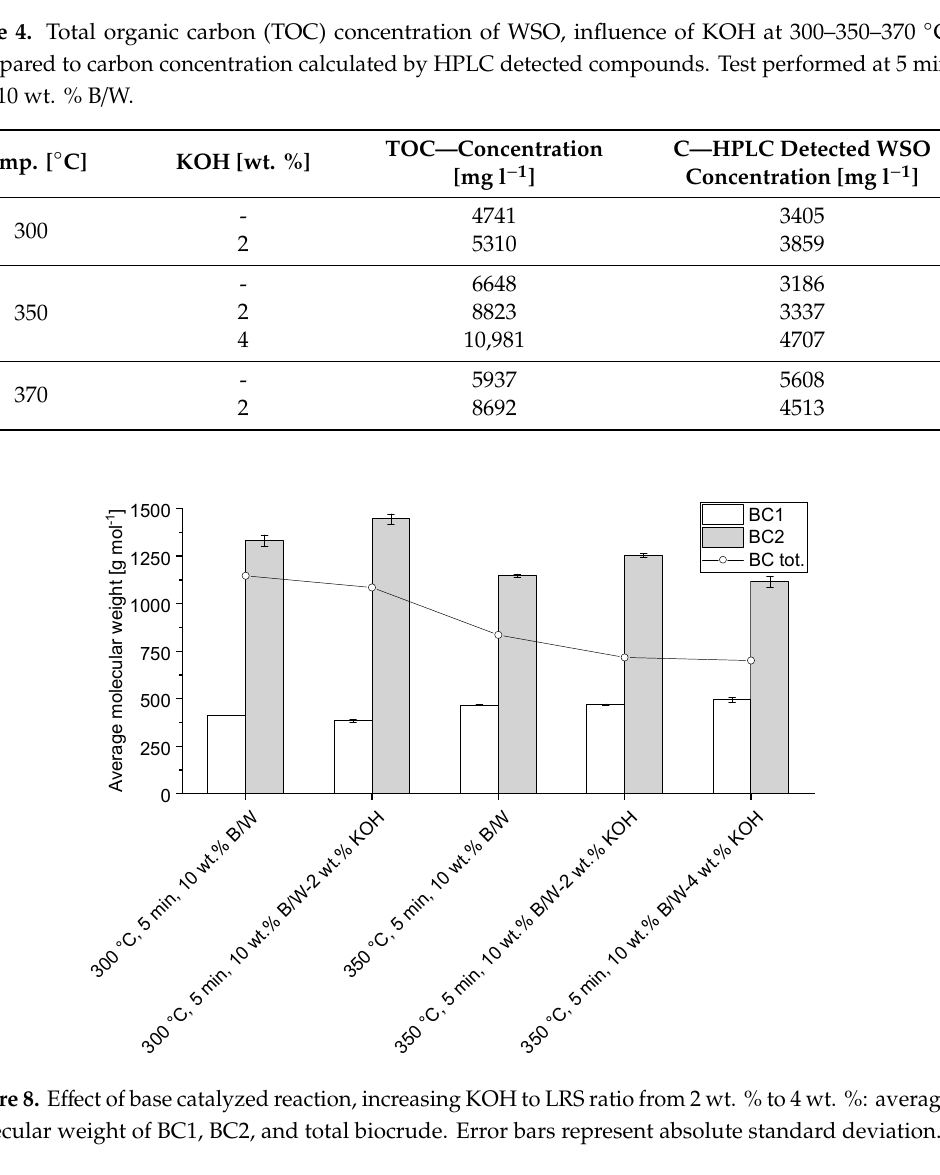
Table 4. Total organic carbon ( TOC) concentration of WSO, influence of KOH at 300–350–370 °C. Compared to carbon concentration calculated by HPLC detected compounds. Test performed at 5 min and 10 wt. % B/W.